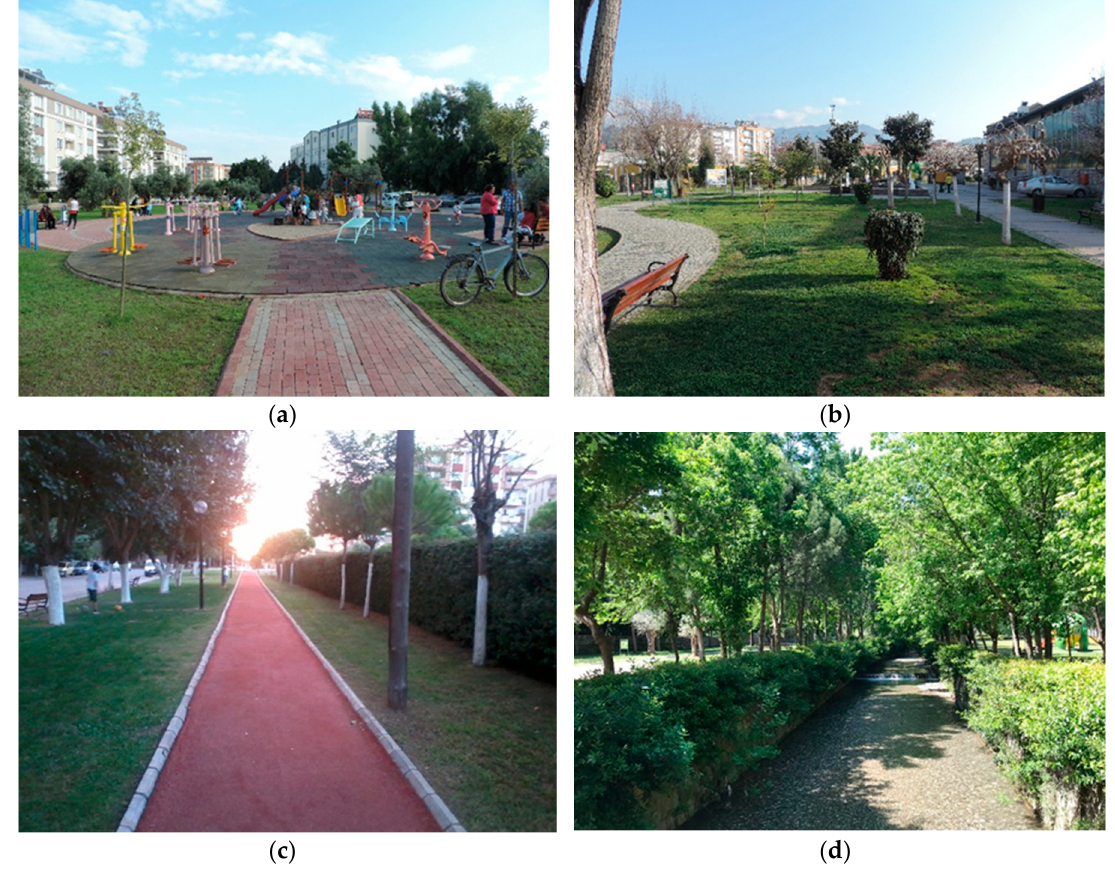
Figure 2. Some of the study sites where the data were collected ( a ) Mehmet Selim Kiraz Park, ( b ) Nevzat Biçer Park, ( c ) Gazi Ko ş uyolu Greenway, ( d ) P ı narba ş ı Recreational Area.